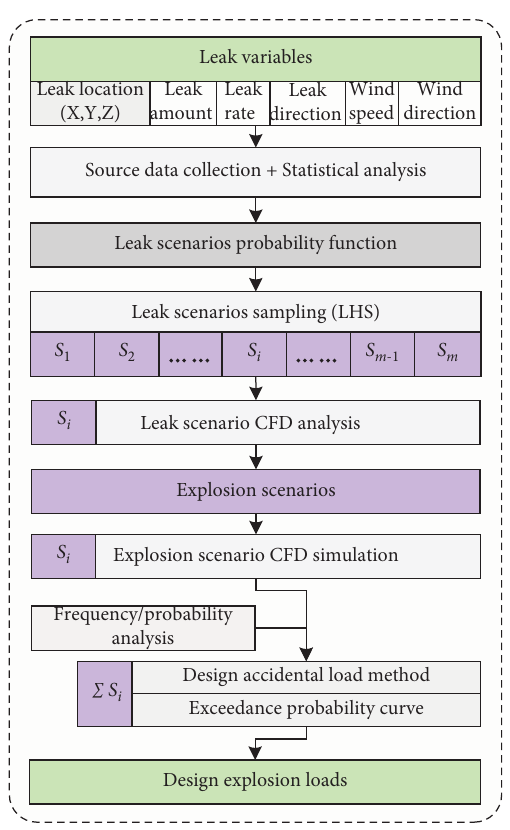
Figure 2: Procedure for quantitative analysis of gas explosion